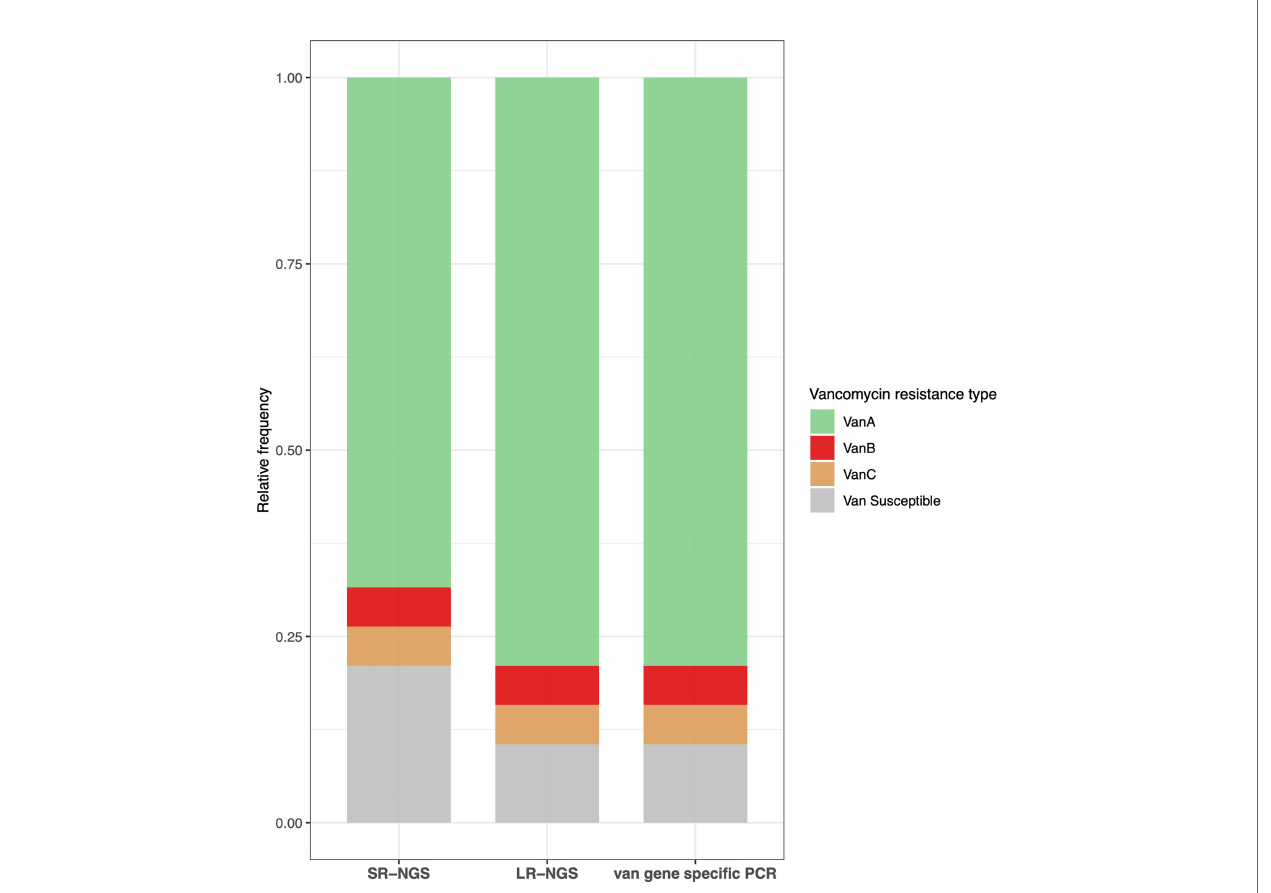
FIGURE 4 | Concordance between the vancomycin resistance results obtained by short-read next-generation sequencing (SR-NGS), long-read next-generation sequencing (LR-NGS), and van gene speci fi c polymerase chain reaction (PCR). The types of vancomycin resistance revealed by LR-NGS accorded with those con fi rmed by van gene speci fi c PCR, while few vanA isolates were classi fi ed as vancomycin susceptible by